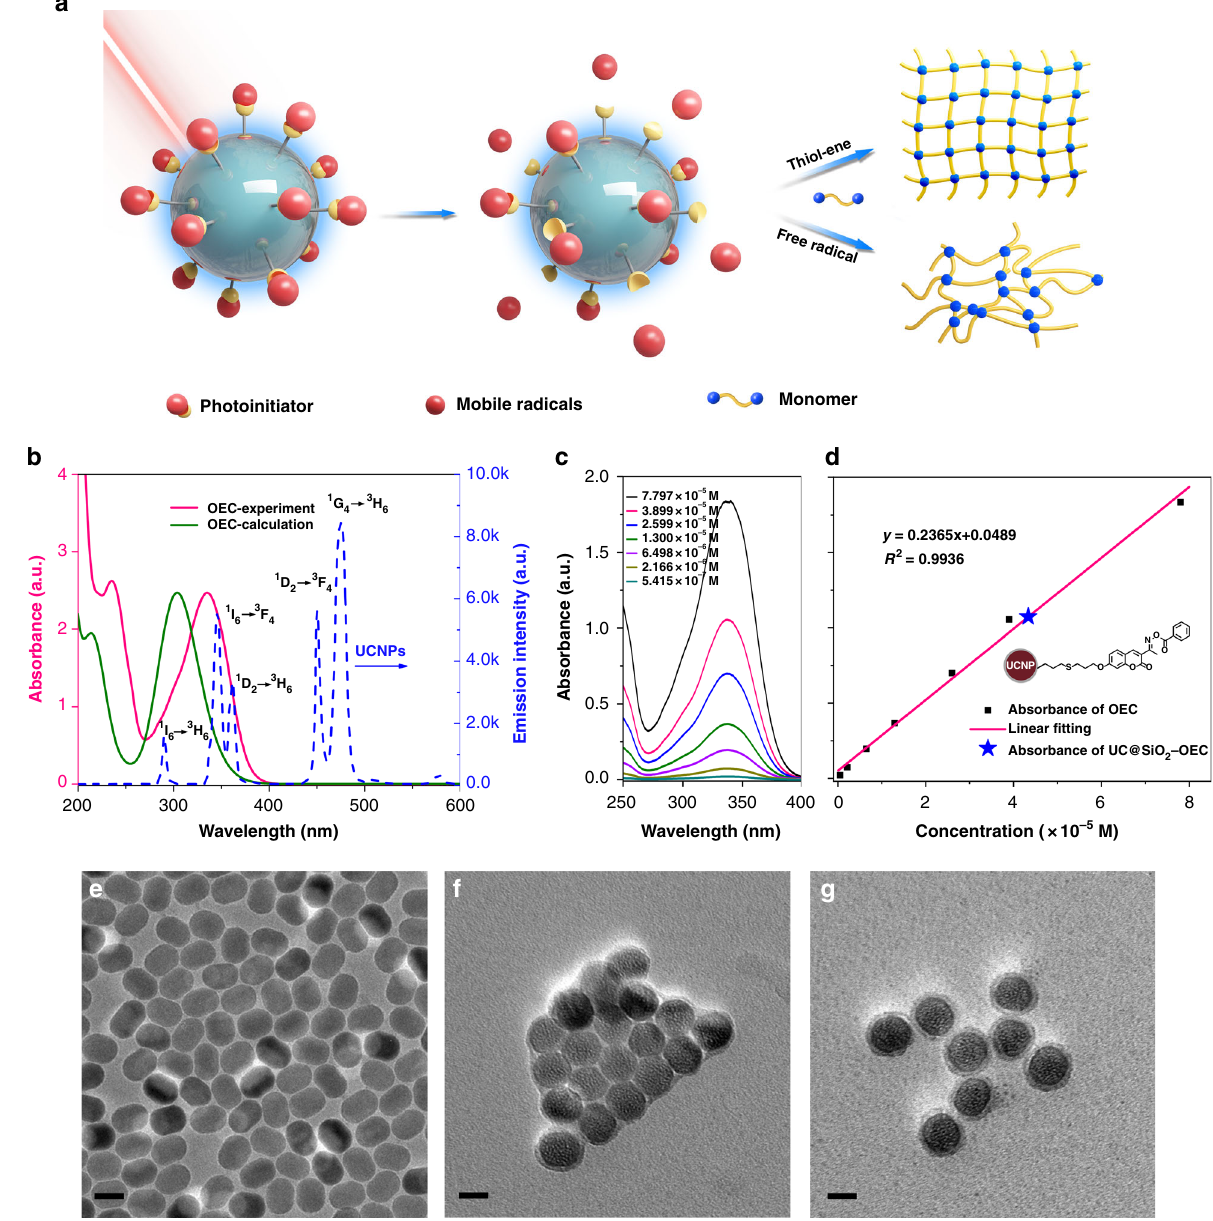
Fig. 1 The structure characterizations of dandelion-like NIR light PIs. a The schematic illustration of photopolymerization by dandelion-like NIR light PIs. b The overlap of calculated and experimental UV – Vis absorption spectra of OEC, and the fl uorescence emission spectrum of UCNPs. c , d UV – Vis absorption spectra of OEC at different concentrations and the related standard curve. e – g TEM images of UCNPs, UC@SiO 2 -SH, and UC@SiO 2 -OEC. Scale bar, 20